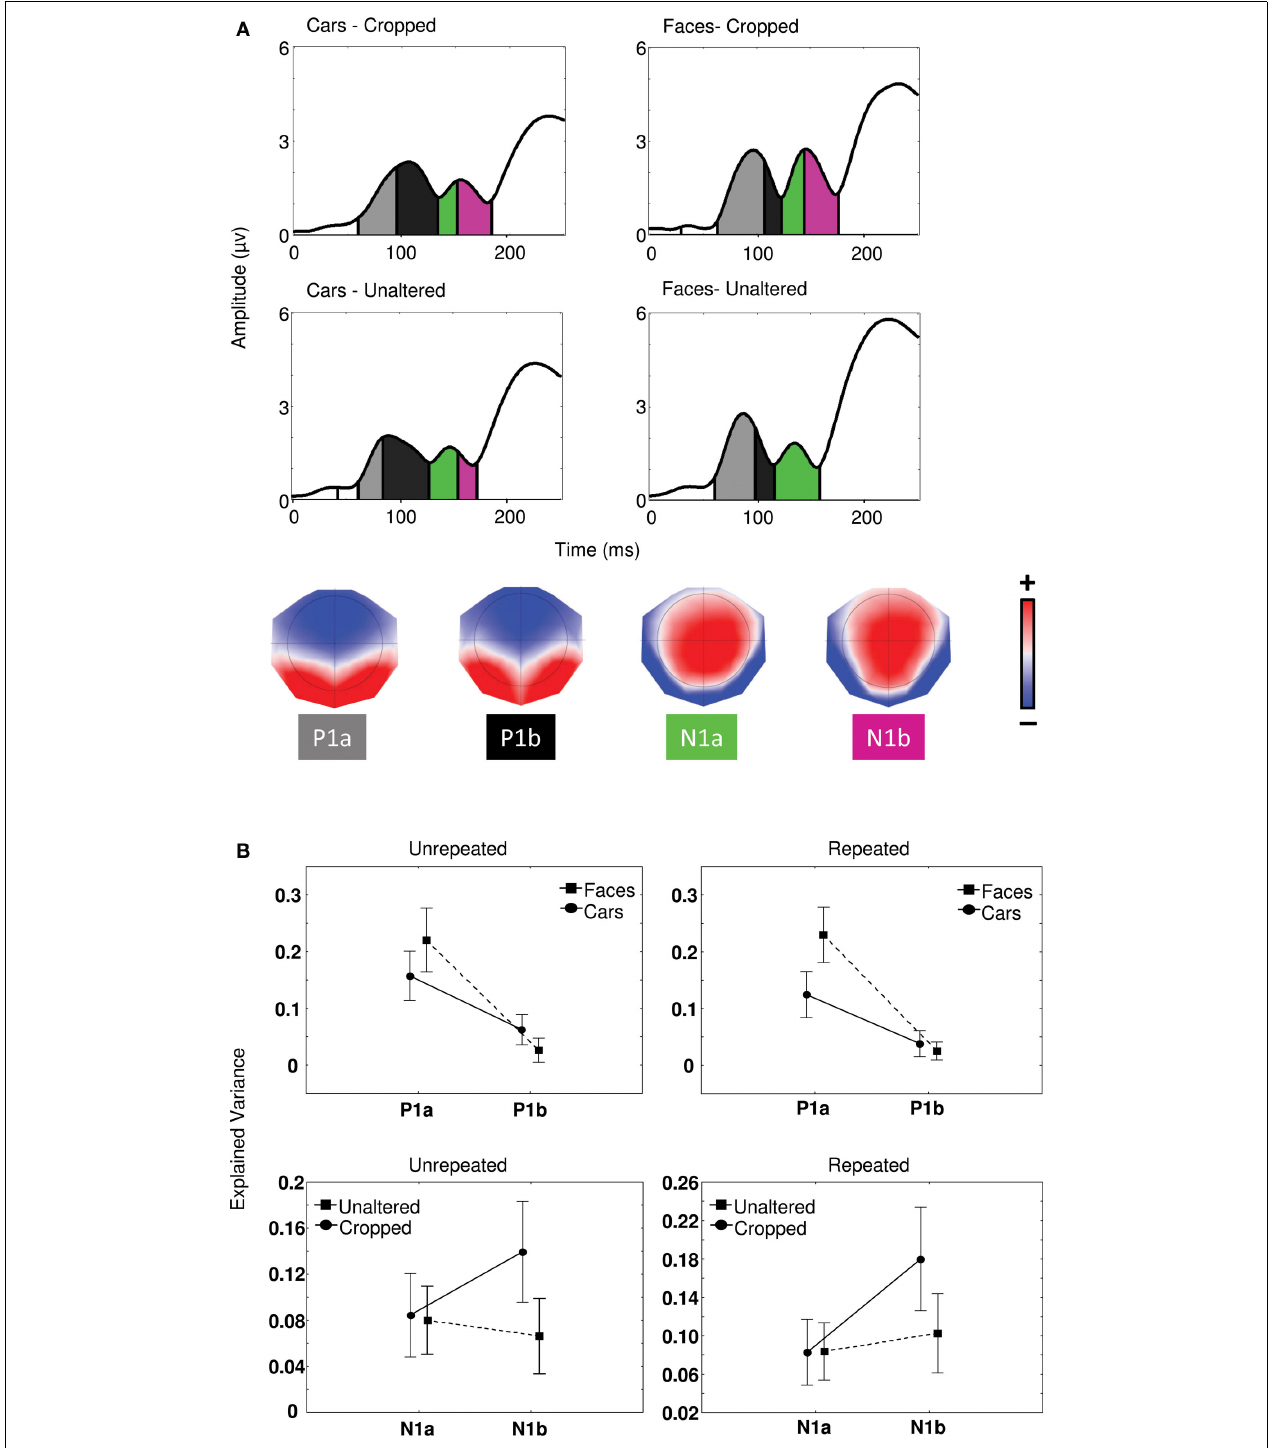
FIGURE 3 | (A) Global field power waveforms in the four conditions of Experiment 1 segmented by microstate and associated topographies identified by the segmentation procedure (see Materials and Methods). Color scale indicates potentials and ranges from − 0.17 to + 0.17 μ V. (B) Proportion of explained variance by maps P1a and P1b regarding object categories and maps N1a and N1b in relation to cropped and unaltered